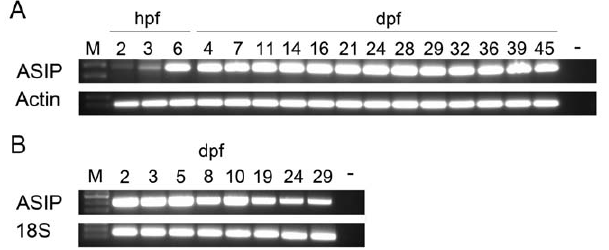
Figure 3. Expression of asip1 gene during early development. RT-PCR analysis of the temporal expression pattern of a sip1 in turbot (A) and sole (B). Hours post-fertilization, hpf; days post-fertilization, dpf.